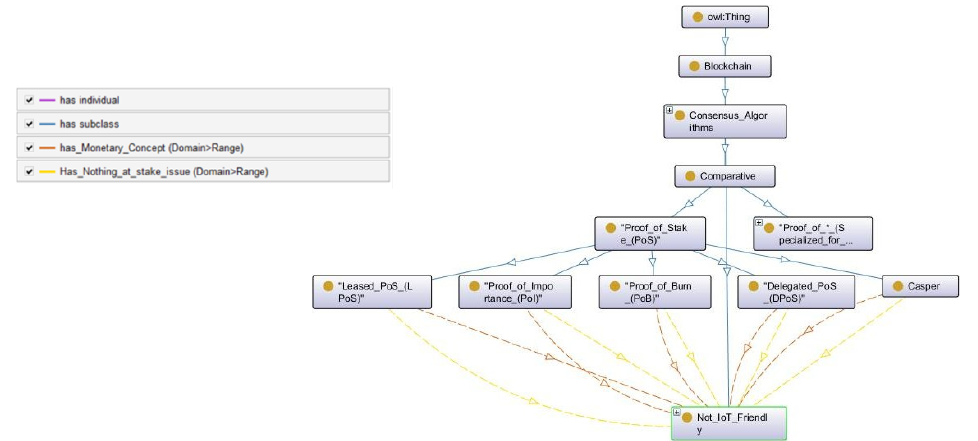
Figure 5. Ontology of comparative consensus class algorithms and IoT